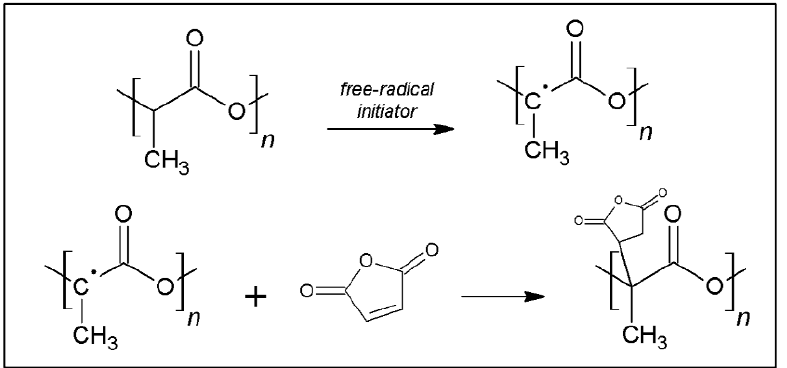
Figure 5. Reaction scheme for the grafting of MA on PLA (from González-López et al. [21], copyright Taylor and Francis, reproduced with permission).